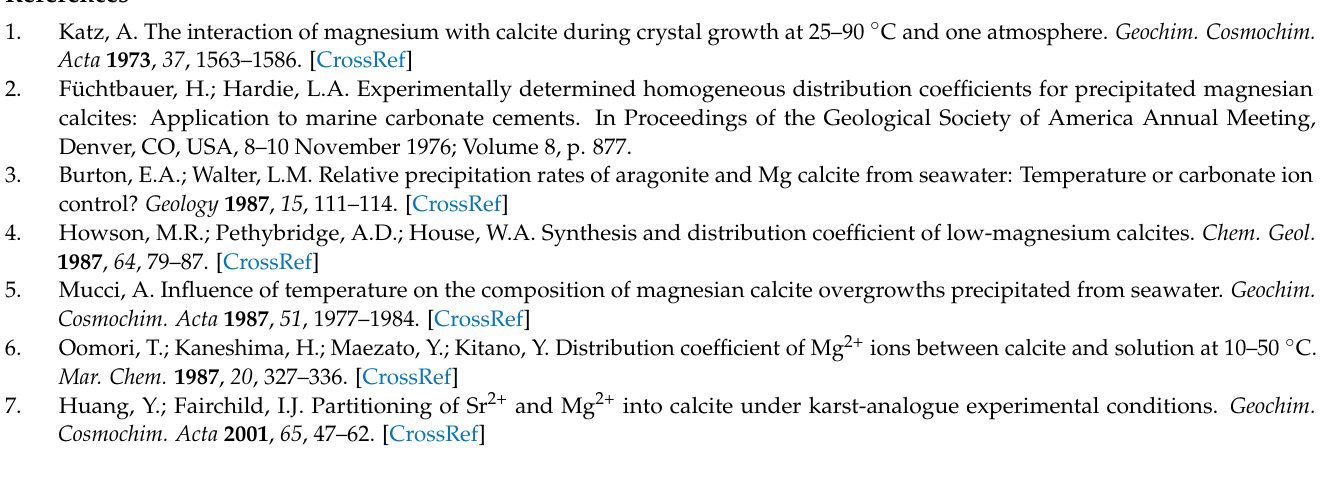
different calcium carbonate polymorphs. Figure S4: Series 10. Powdered X-ray diffraction